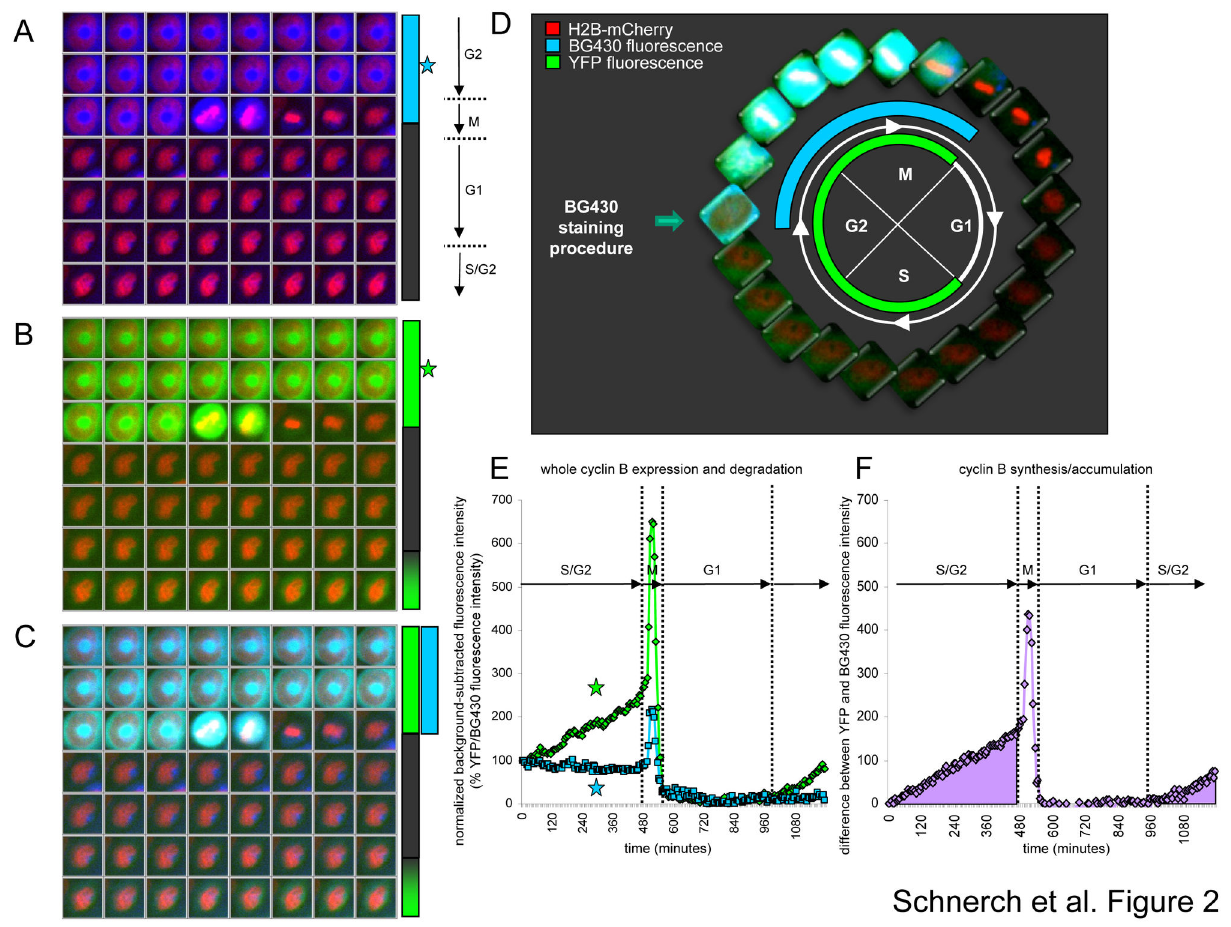
Figure 2. Degradation and synthesis of the double-chimeric cyclin B reporter throughout the cell cycle by live-cell imaging at the single-cell level. (A) Degradation of the reporter is reflected by a decrease in BG430 fluorescence intensity at the metaphase to anaphase transition following pulse-chase labeling. (B) Whole protein expression of the CYS reporter molecule is reflected by YFP fluorescence intensity throughout the cell cycle. (C) An overlay of YFP (green), BG430 (blue) and mCherry (red) fluorescence is depicted by the lower image series. (D) Whole protein expression, degradation and synthesis/accumulation of the CYS reporter and pulse-chase labeling with the SNAP substrate is depicted for the indicated cell cycle stages by overlaying of YFP and BG430 fluorescence. (E) YFP (green curve) and BG430 (blue curve) fluorescence intensity curves are shown and the corresponding cell cycle stages are indicated (see cell cycle stage between the dotted lines). Background fluorescence was subtracted and the initial fluorescence intensity level was set to 100%. (F) A curve displaying the synthesis rate/accumulation of the cyclin B reporter (as defined by the difference between YFP- and BG430-fluorescence) is indicated. doi: 10.1371/journal.pone.0074379.g002 manner (Figure 3A, B, C). Fluorescence intensity curves behaved in a very similar fashion during prometaphase/ metaphase. The depicted cell expressed CYS from an expression cassette lacking the human endogenous cyclin B 3'UTR sequence (Figure 3D). Background fluorescence, as defined by the mean fluorescence level in G1 phase, was subtracted and intensity levels were normalized based on